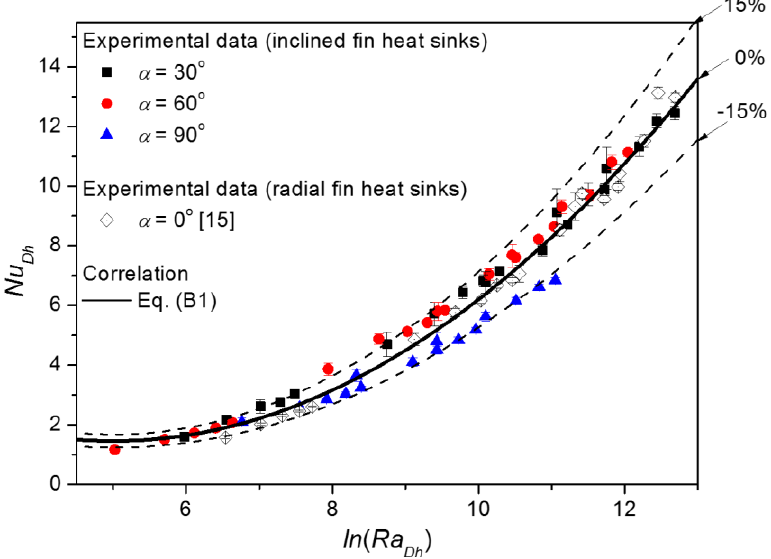
Figure B2. Nusselt numbers calculated using alternative correlation and those from experimental data.